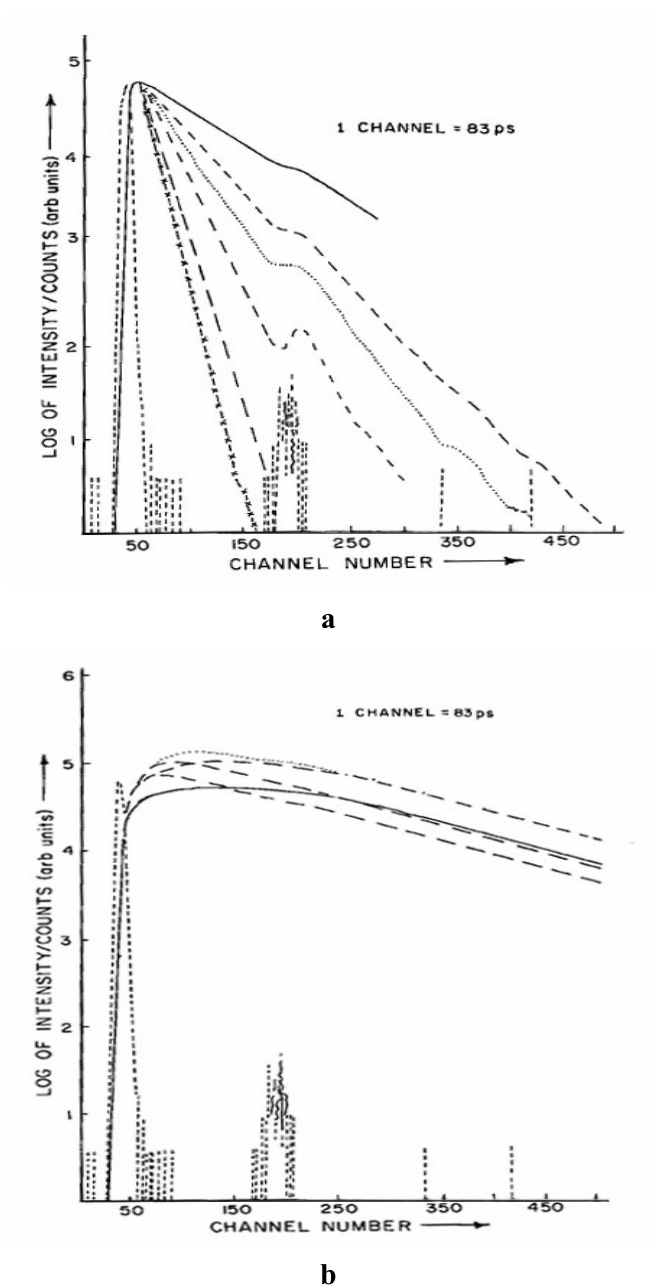
Figure 3. Fluorescence decay curves of the a) neutral CAZL monitored at 360 nm ( λ b) anionic species of CAZL monitored at 415 nm ( λ from top to bottom in (a) are: 0.0N, 0.005N, 0.01N, 0.02N, 0.04N and 0.06N respectively (…….. is the pump profile). Different signs of the various decay curves in (b) correspond the same signs in the decay curves in (a) with the given